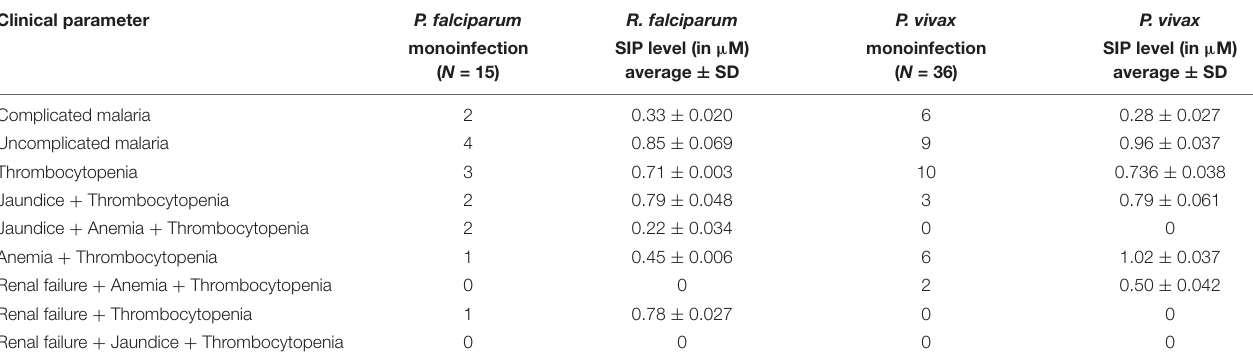
TABLE 1 | Clinical data of the malaria patients and healthy controls showing the S1P level. Clinical